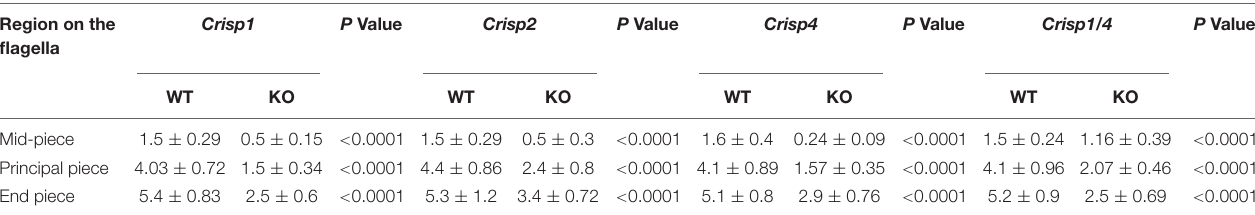
Please refer to Supplementary Table 4 for all the possible interactions between wild type vs. knock out genotype.